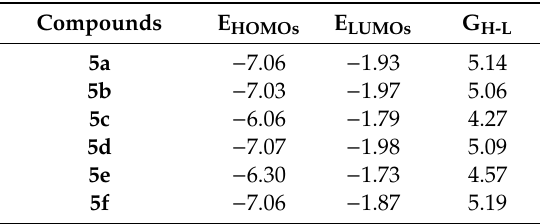
Table 2. The energies of HOMOs (E HOMOs , in eV), energies of LUMOs (E LUMOs , in eV,) HOMOs–LUMOs gap (G H-L ), and dipole moment ( µ , in Debye) of compounds ( 5a – f ). Compounds E HOMOs E